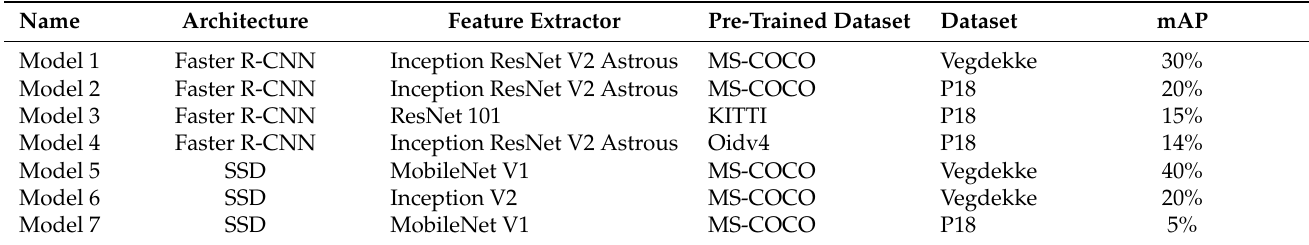
Table 24. Comparison of the fine-tuned object detection